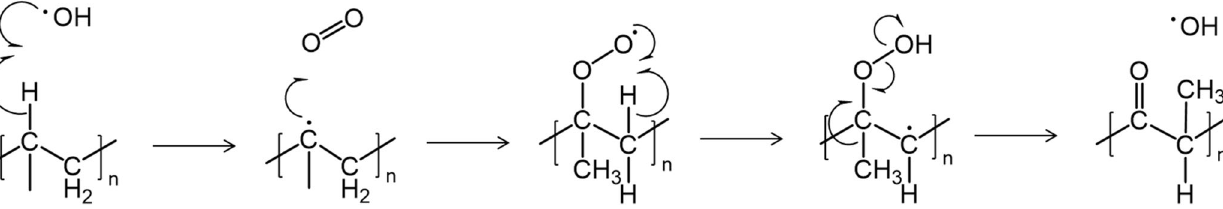
Fig. 8 Proposed cold- fl ame oxidation mechanism. Proposed mechanism for the cool- fl ame oxidation for a polypropylene framework to form a carbonyl group at the initial